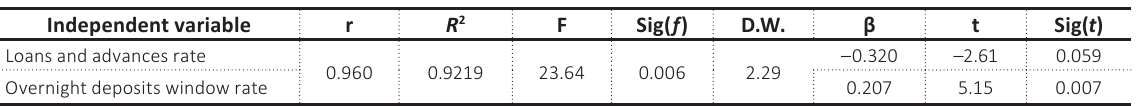
Table 6. Multiple linear regression for testing the effect of the Central Bank of Jordan on ROA in banks operating in Jordan (2005–2011) Independent